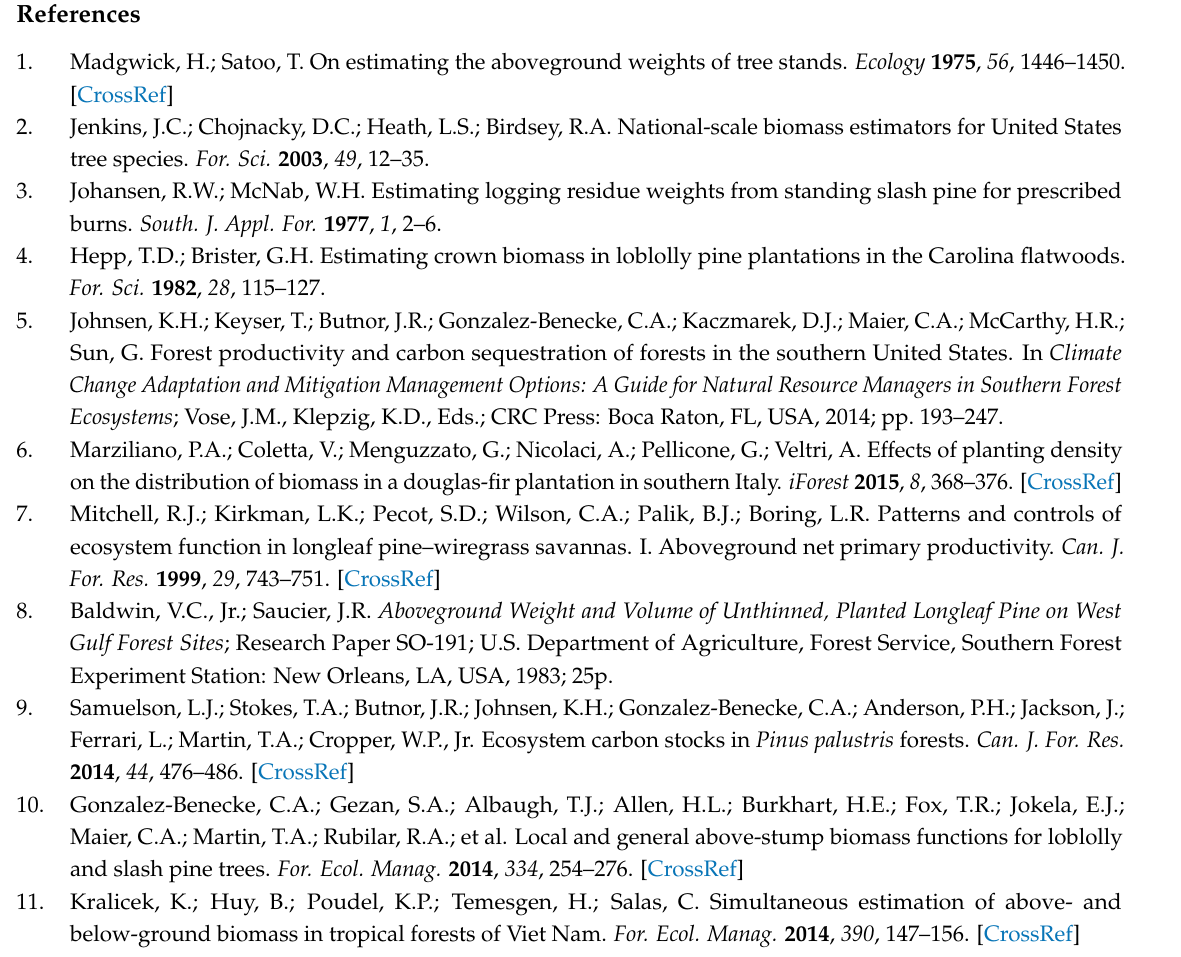
Figure S1: Pearson residual plots against age (left panel) and Basal Area (BA, right panel) for each biomass component in the model system VI fitted using NSUR method. There were not any obvious trends in the plots of biomass residuals against Age or